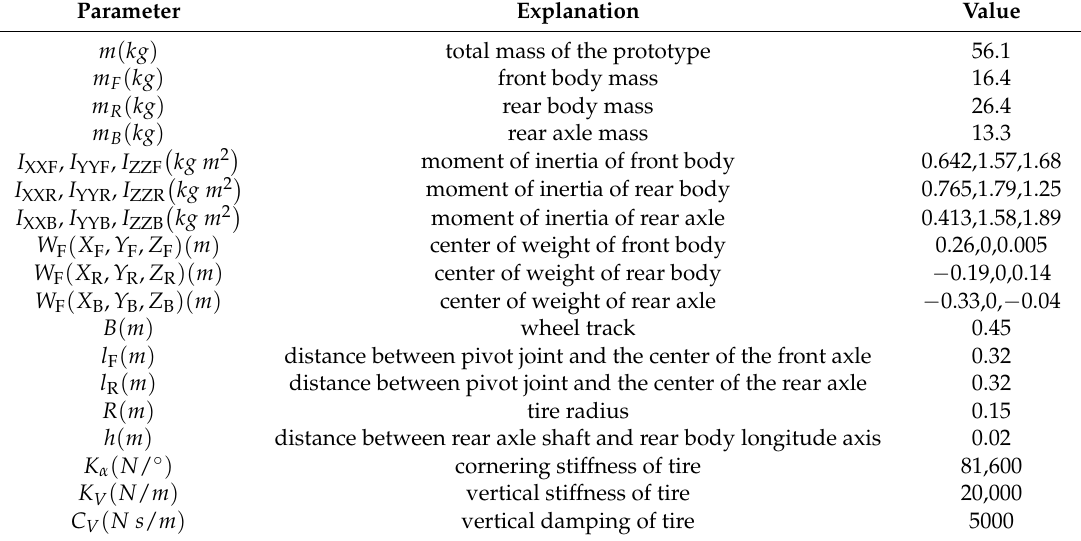
Table 2. Dimensions and